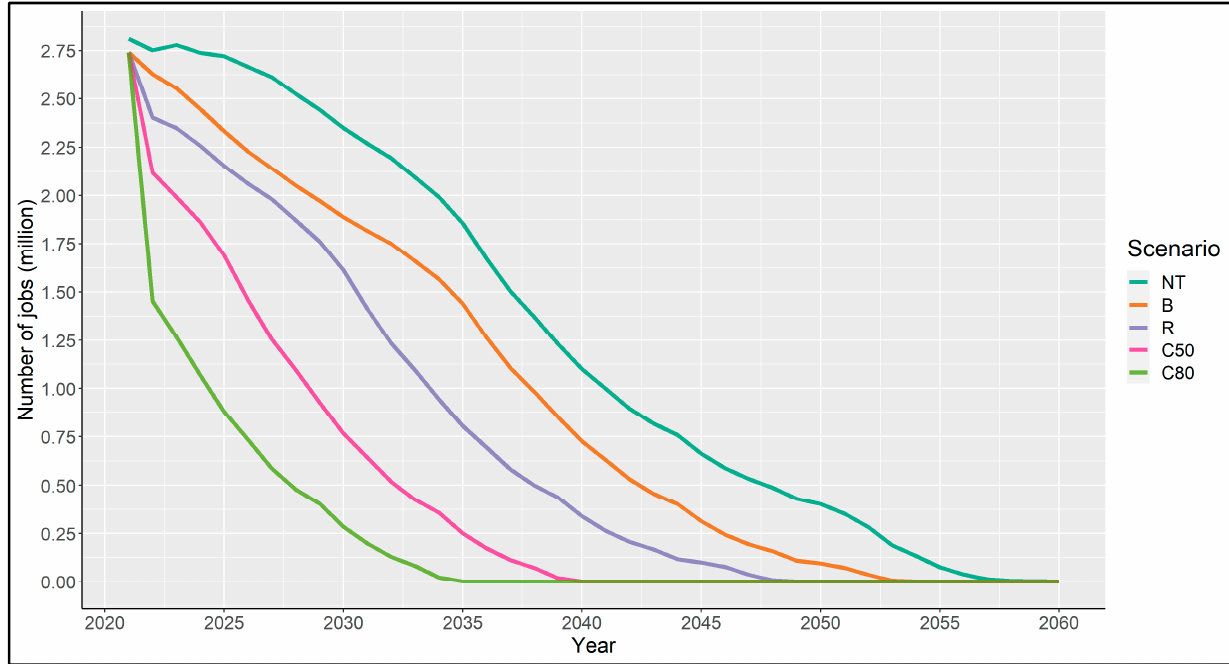
Figure 6. Employment in the thermal coal mining, power, and transport sectors under five coal phase-out scenarios, 2021–2060.